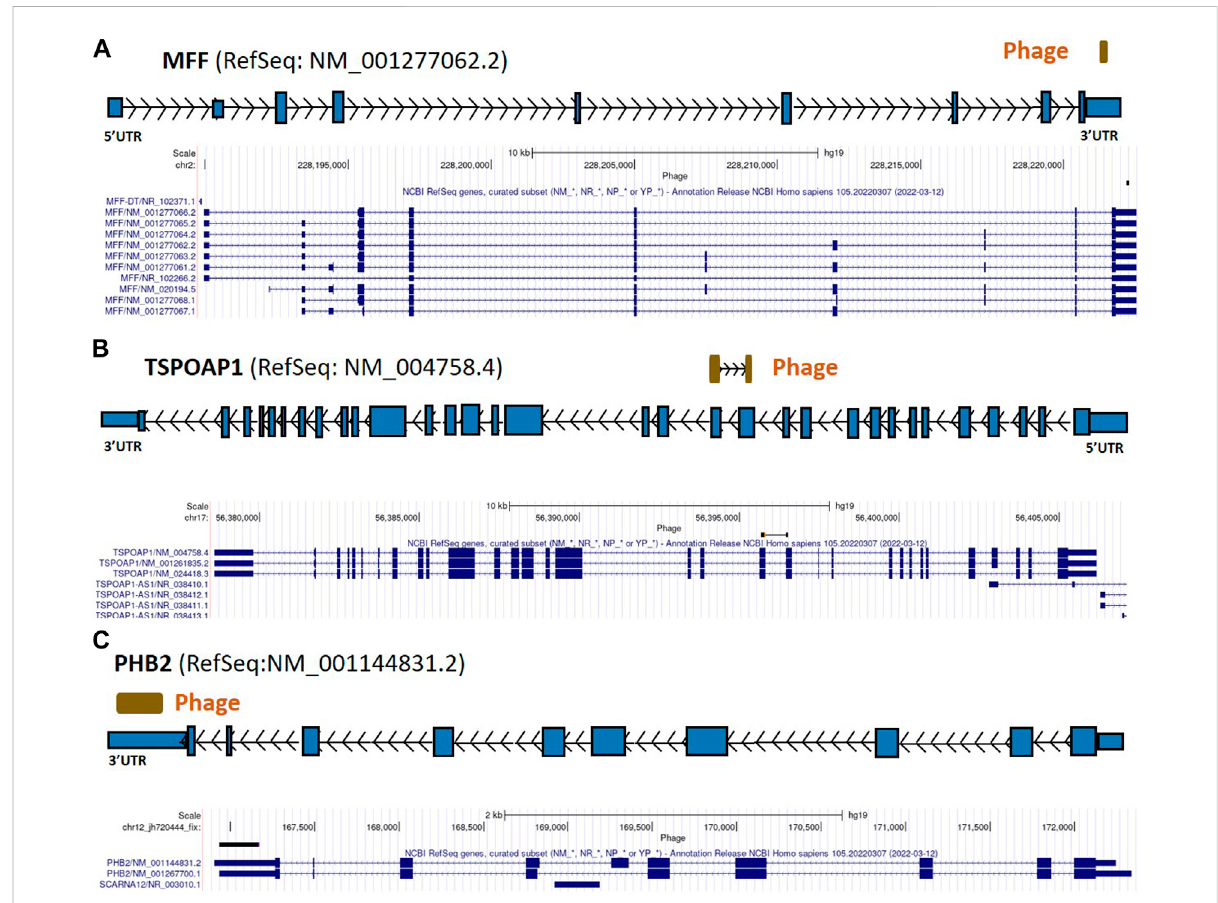
FIGURE 4 MFF , TSPOAP1 , and PHB2 gene regions as autoreactive BC antigens identi fi ed by UCSC Genome Browser BLAT mapping and annotation of uniquely patient-sera-reactive phages. (A) Identi fi ed phage mapping within the 3 ′ -UTR region of the MFF gene. (B) Identi fi ed phage mapping to the protein-coding region of TSPOAP1 . (C) Identi fi ed phage mapping within the 3 ′ -UTR region of the PHB2 gene. MFF , mitochondrial fi ssion factor; TSPOAP1 , peripheral-type benzodiazepine receptor-associated protein 1; PHB2 , prohibitin 2; UTR, untranslated region; kb,